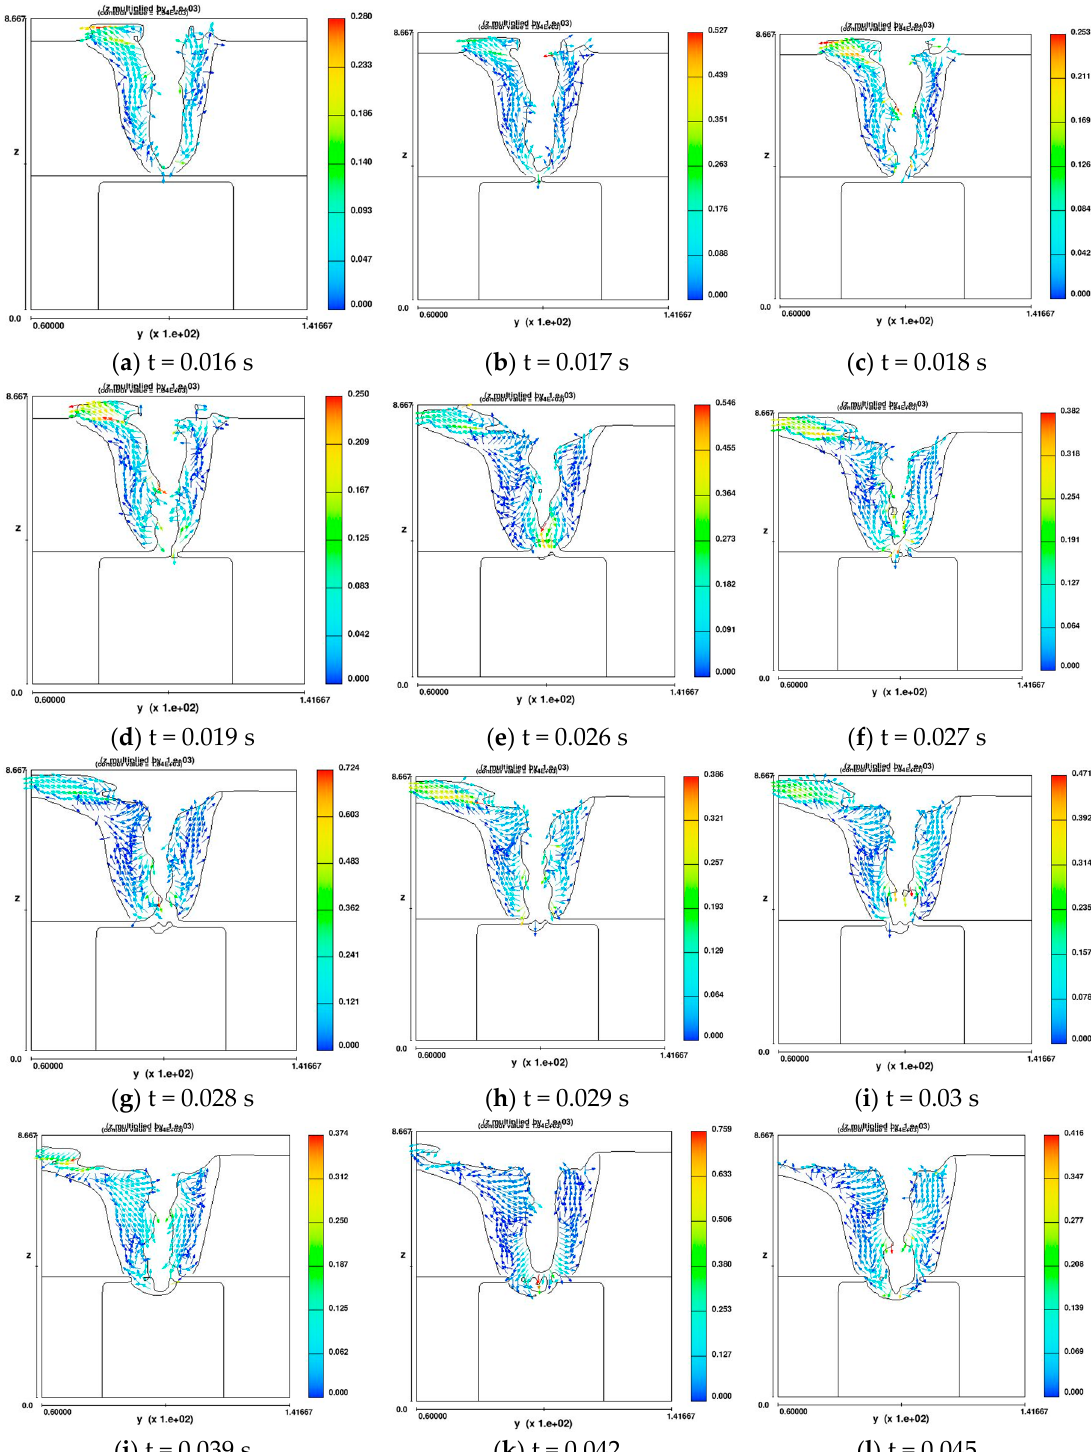
Figure 5. The velocity field corresponding to Figure 3.